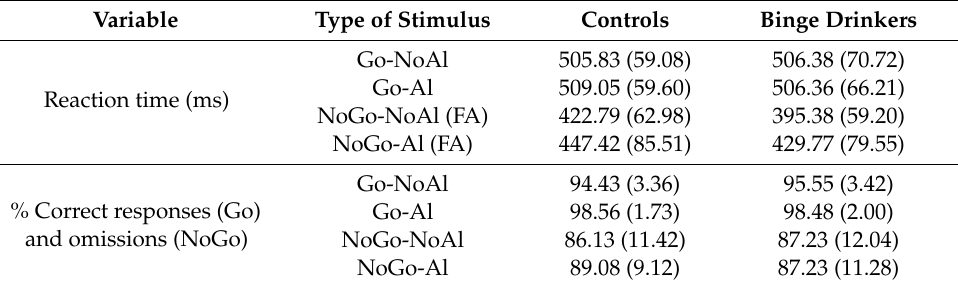
Table 5. Mean (SD) reaction times (on hits and false alarms (FA) in milliseconds (ms)) and accuracy (% of hits and correct omissions) for each group. There were no significant di ff erences in behavioural performance between